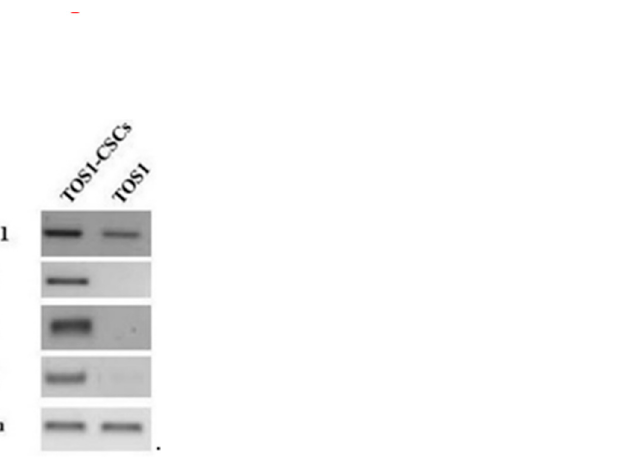
cell line. CSC cell line.